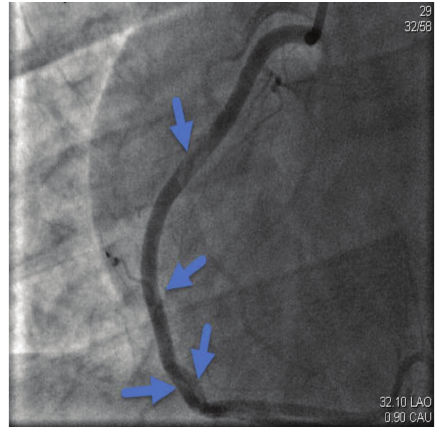
Figure 2: Showing 95% mid-spiral right coronary artery dissection.